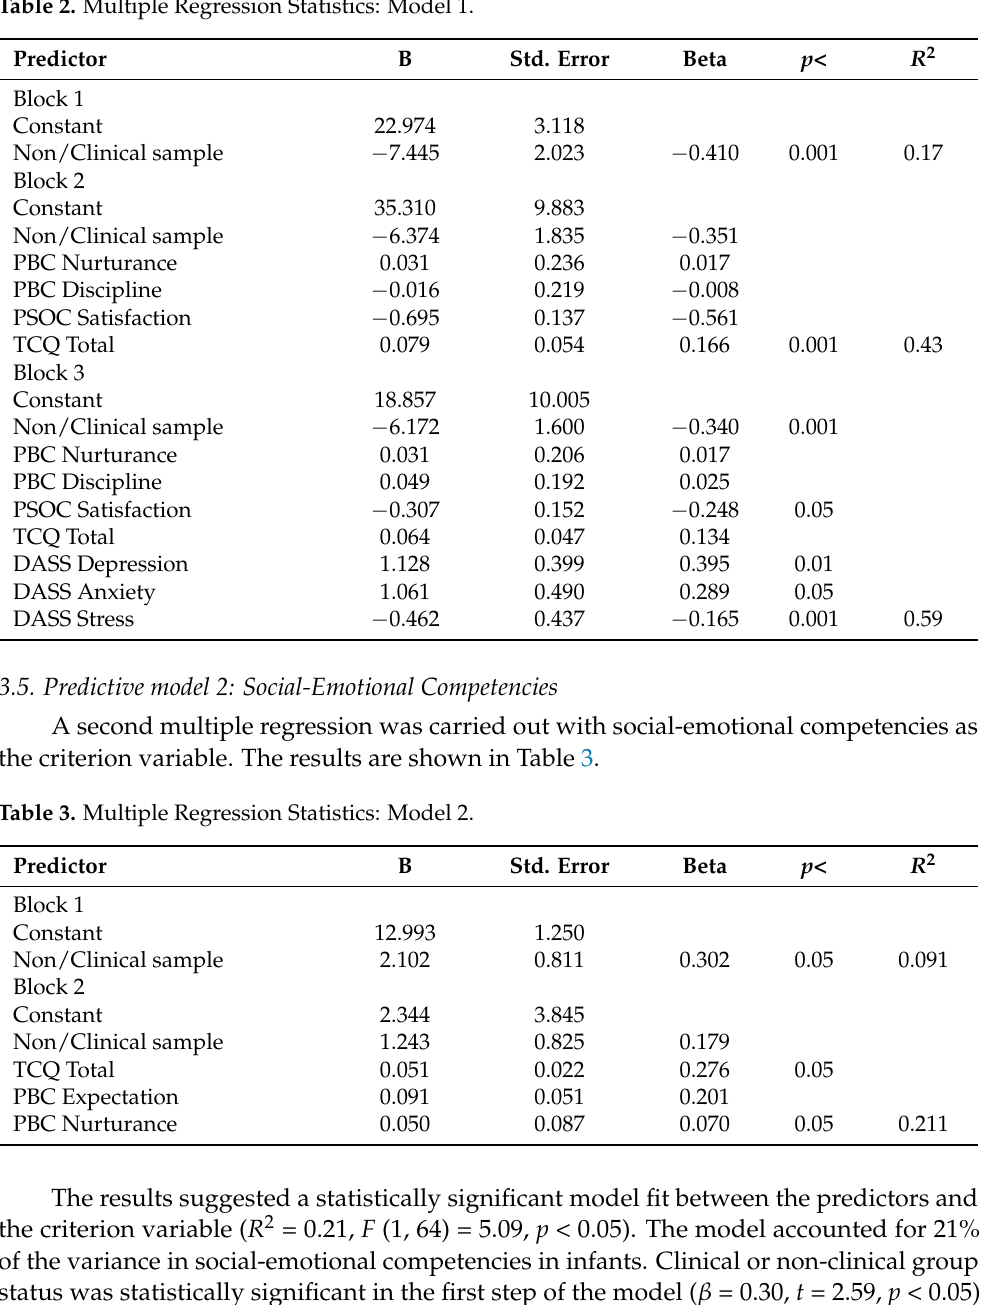
Table 2. Multiple Regression Statistics: Model 1.